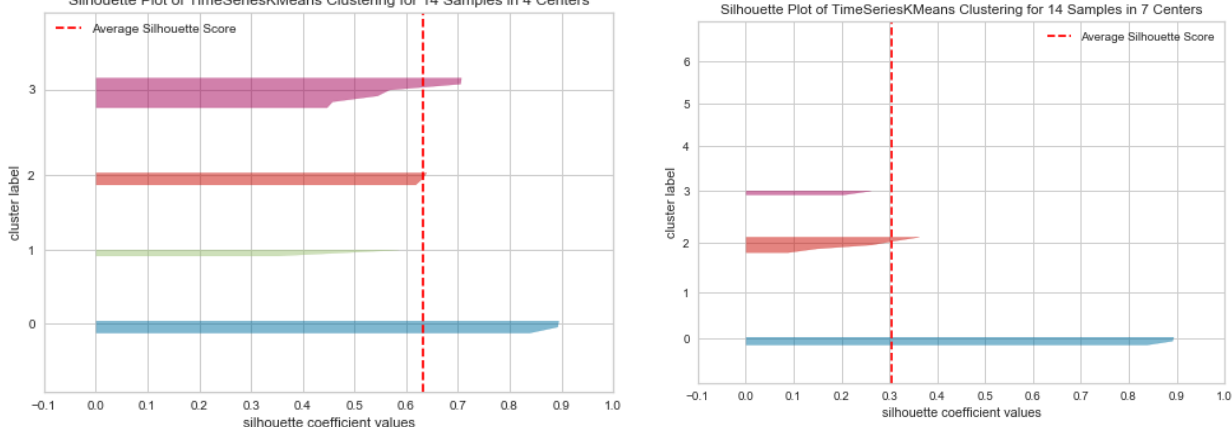
Figure 9. Silhouette analysis for K-Means clustering on time span vectors with k = 4 ( left ) and k = 7 ( right ). Cluster labels are colored differently. The average Silhouette score is shown with the dotted red line.